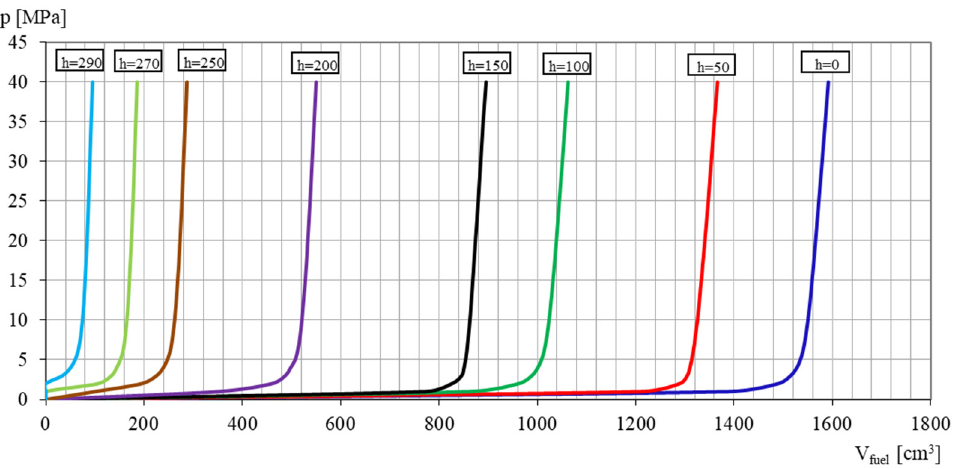
Figure 8. Change in the pressure in the measured volume at predefined piston positions for the 8% content of CO 2 in the exhaust gas.